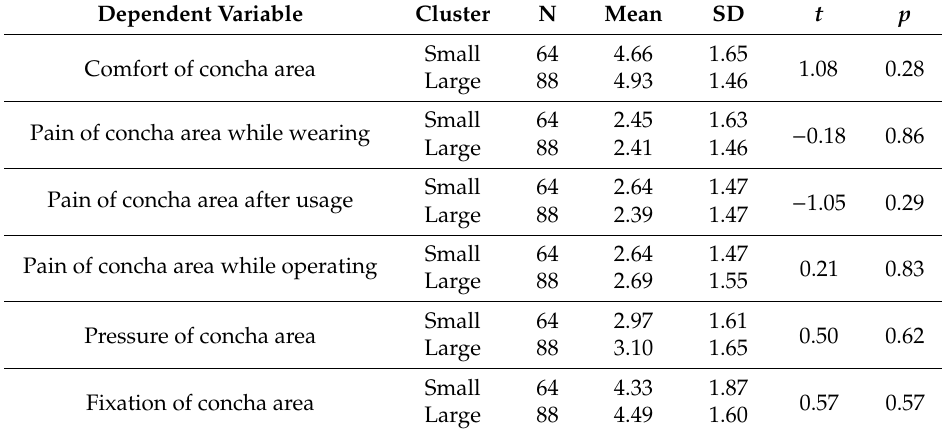
Table 9. Results of independent sample t -test for wearing comfort di ff erence according to concha width clusters.